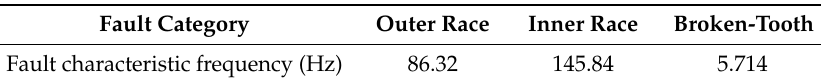
Table 3. Fault characteristic